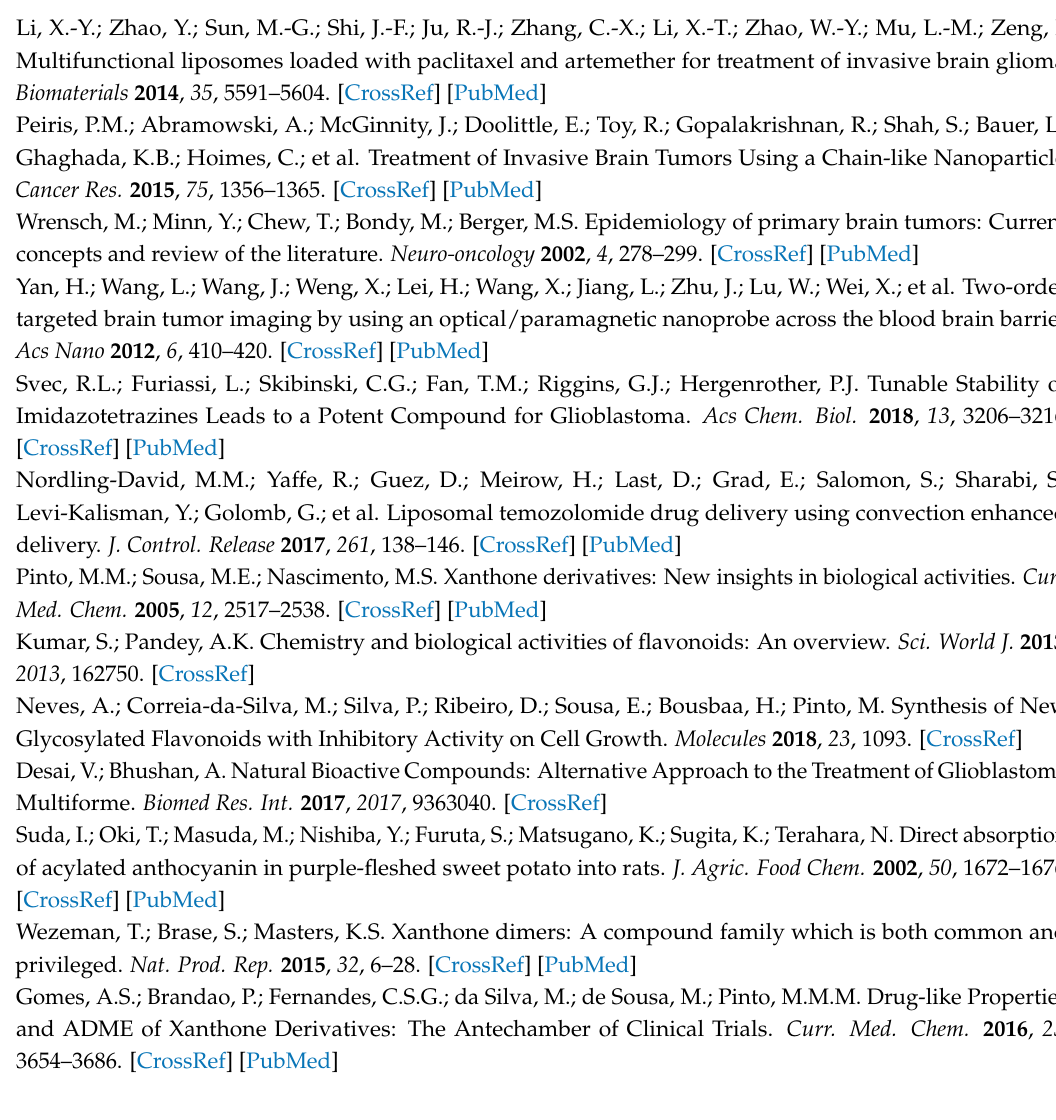
Figure S2. HRMS for compound 2 ; Figure S3. Simple Bar of Entrapment Efficiency (EE) vs Type of particle (proliposome or liposome); Table S1. Multiple Comparisons for Table 2 (Mean diameter); Table S2. Multiple Comparisons for Table 3 (Mean diameter); Table S3. Levene test and t-test for Entrapment Efficiency (EE) (Independent Samples); Table S4. Multiple Comparisons for Figure